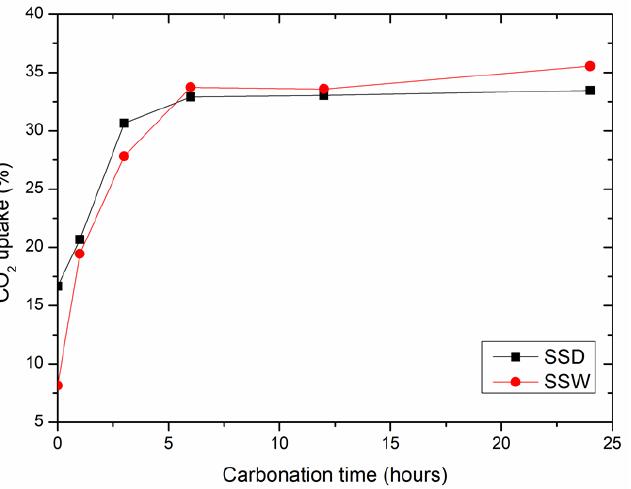
Figure 3. The effect of carbonation time on CO 2 uptake of compacts made from the SSD and SSW. The standard deviations of CO 2 uptake ranged from 0.26% to 1.28%.